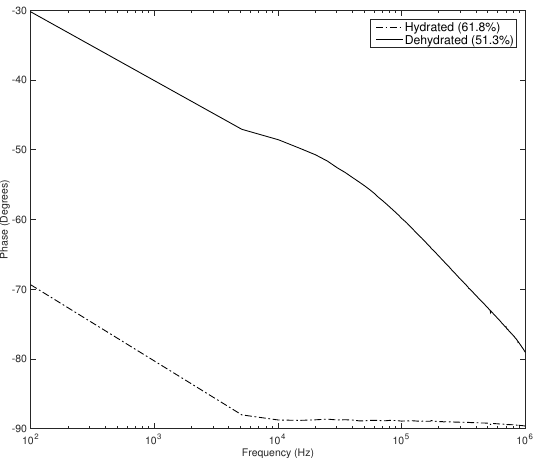
Figure 23. Testing results—phase (°) vs. frequency (Hz) of hydrated and dehydrated subjects (both